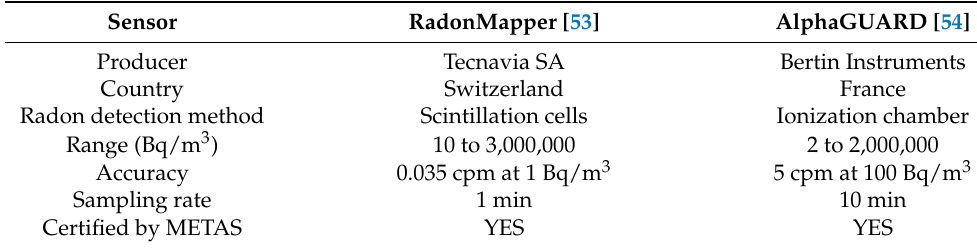
Table A3. Technical characteristics of radon sensors used in this